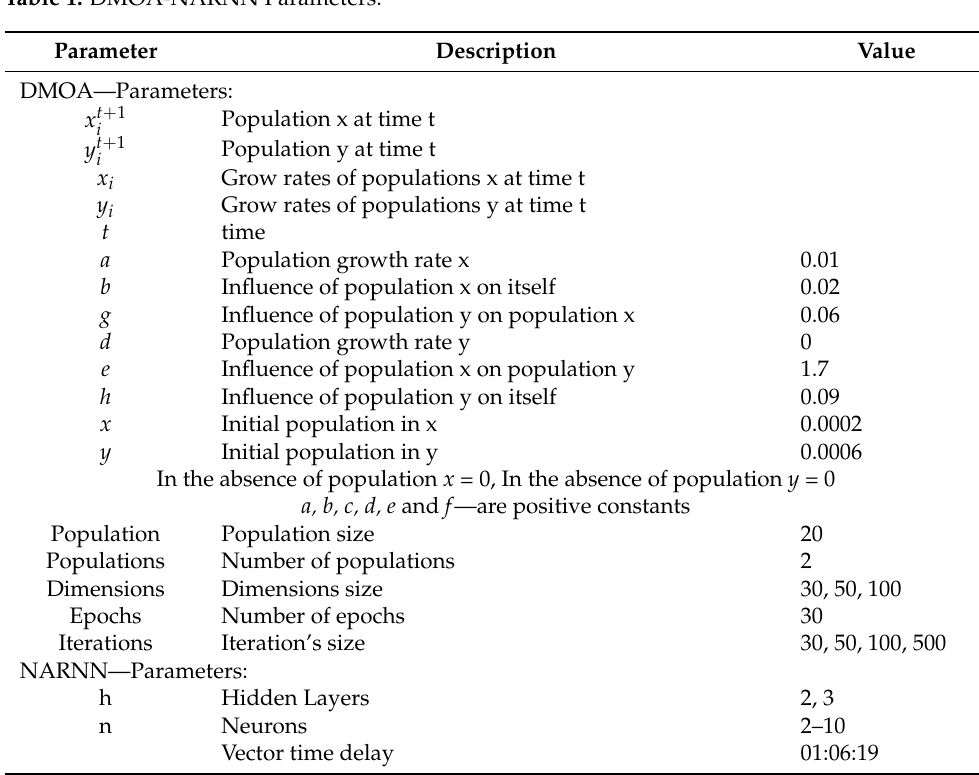
Table 1. DMOA-NARNN